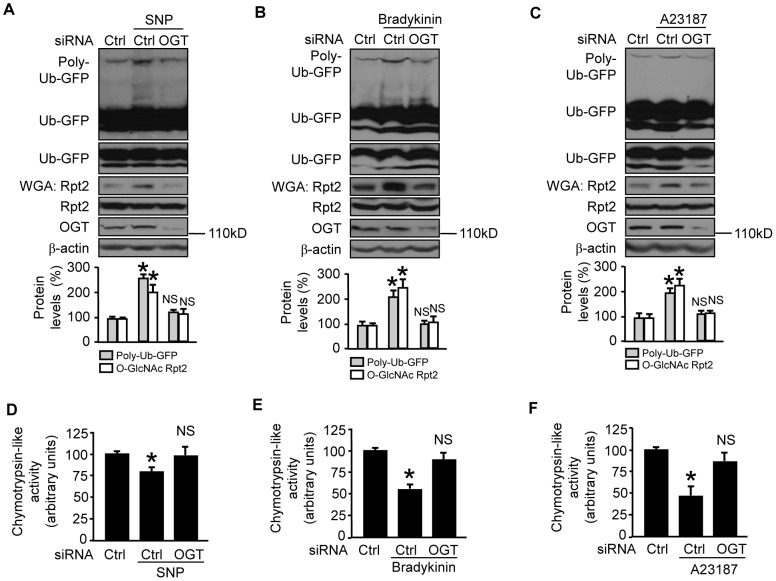
OGT mediates NO-induced suppression of 26S proteasome functionality.OGT siRNA knockdown abolished the proteasome reporter protein accumulation and Rpt2 O-GlcNAcylation induced by (A) SNP; (B) Bradykinin; and (C) A23187. Rpt2 O-GlcNAcylation was detected with the WGA protocol. The shown blots were representative of at least 3 independent experiments with similar results. OGT knockdown by siRNA restored 26S proteasome activity in cell treated with (D) SNP; (E) Bradykinin; and (F) A23187. 26S proteasome activity was quantified by measuring chymotrypsin-like activity in the cell lysates. * represent p<0.05 vs control (n = 3). An overlaid portion (less exposure) of each whole blot indicating Ub-GFP is presented. Ctrl, control (scrambled) siRNA; NS, not significant (v.s. control); OGT, O-GlcNAc transferase; SNP, sodium nitroprusside; Ub-GFP, ubiquitin-green fluorescent protein; WGA, wheat germ agglutinin.